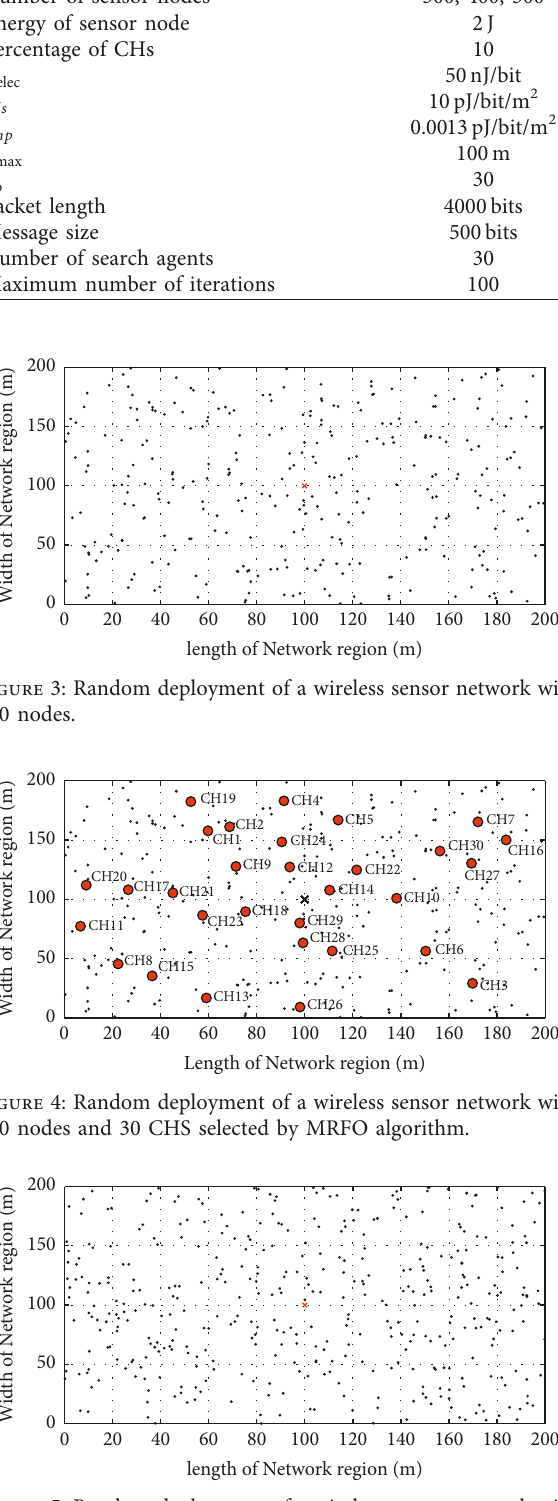
Figure 5: Random deployment of a wireless sensor network with 400